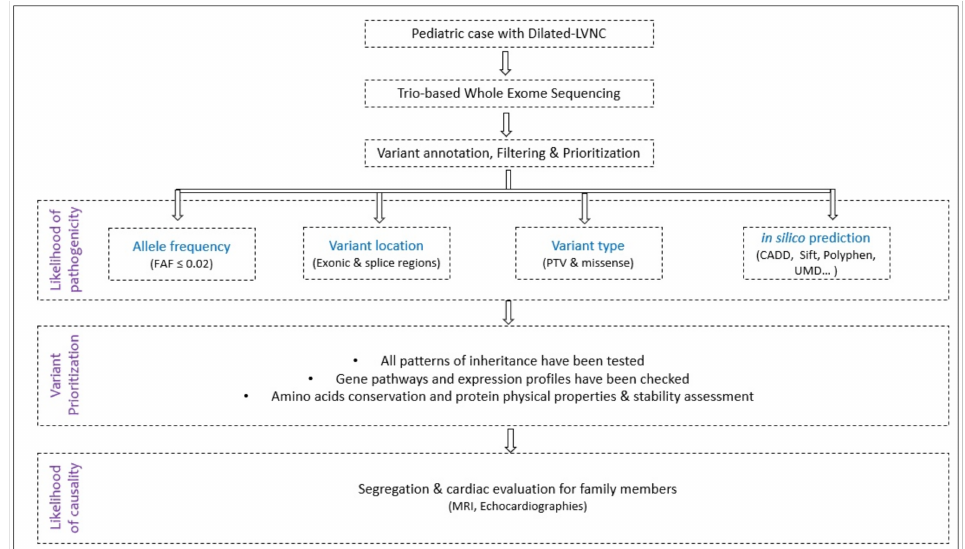
Figure 3. Study design flowchart. (FAF: Filtering Allele Frequency; PTV: Protein-Truncating